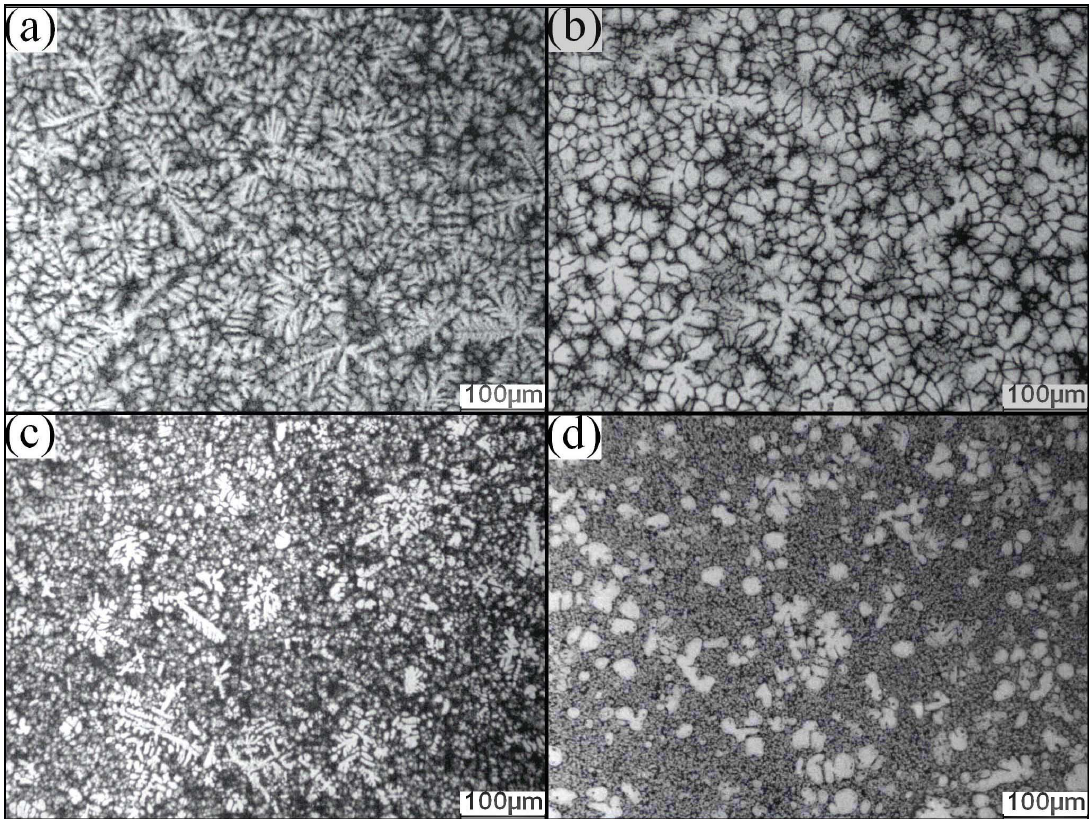
Figure 4. ZA27 alloy microstructures fabricated by different processes (a) liquid permanent mould casting; (b) semisolid permanent mould casting microstructure; (c) HPDC; (d)